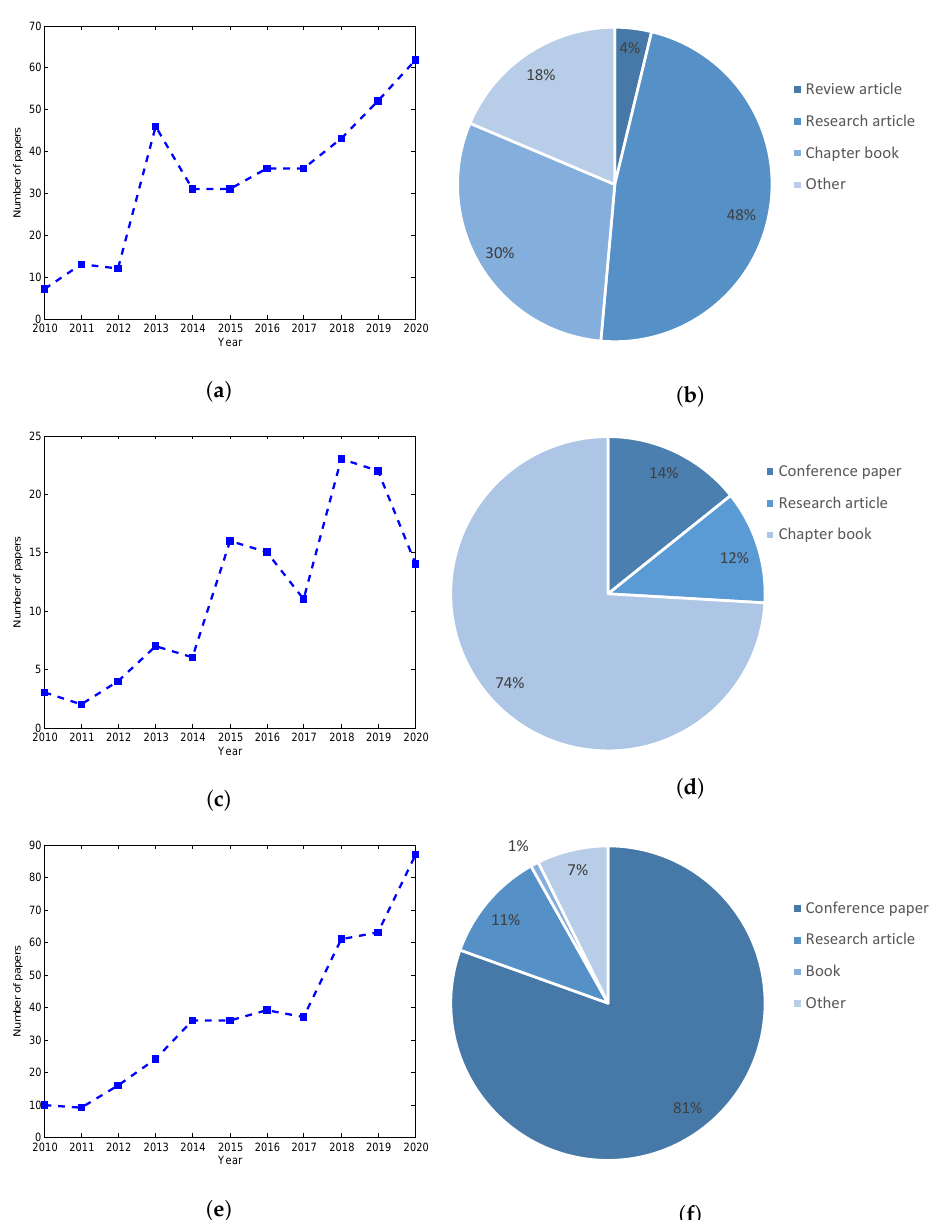
Figure 2. Evolution and classification of published papers: ( a , d ) ScienceDirect, ( b , e ) Springer and ( c , f )